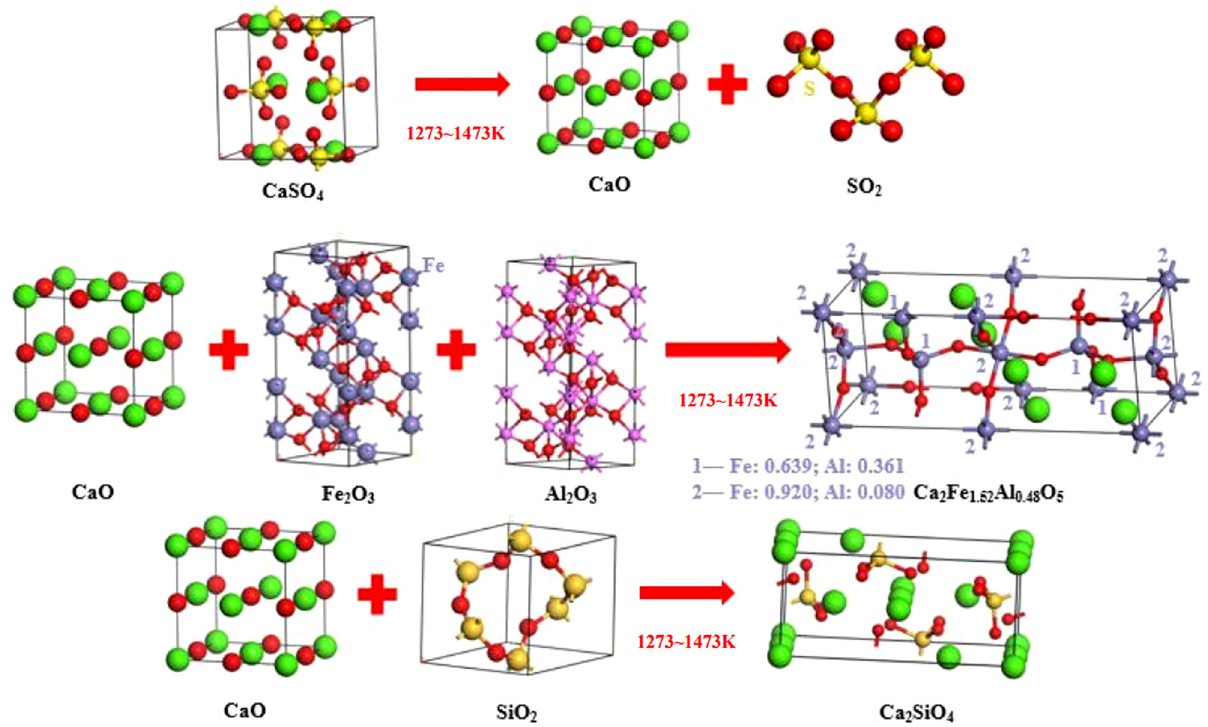
Figure 5: Mineral transformation process at 1,273 – 1,473